Question: Author a descriptive caption for the visualization shown.
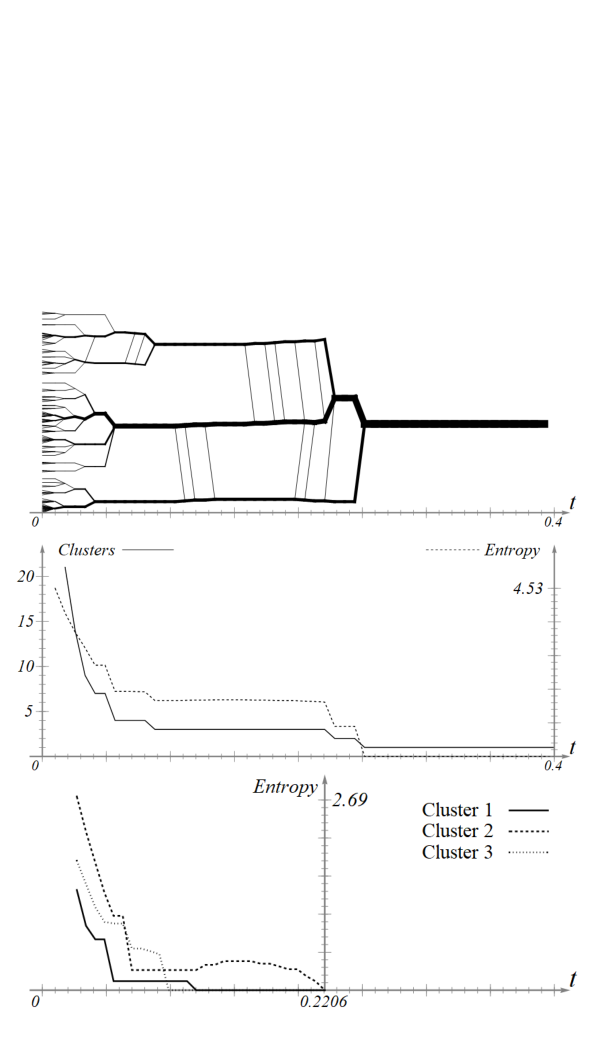
Answer: Top: Chronodendrogram for the noisy dataset. Middle: The entropy and cluster number, showing stability at 3 clusters. Bottom: The local entropy scores for each of the three clusters observed at time t = 0.2206.